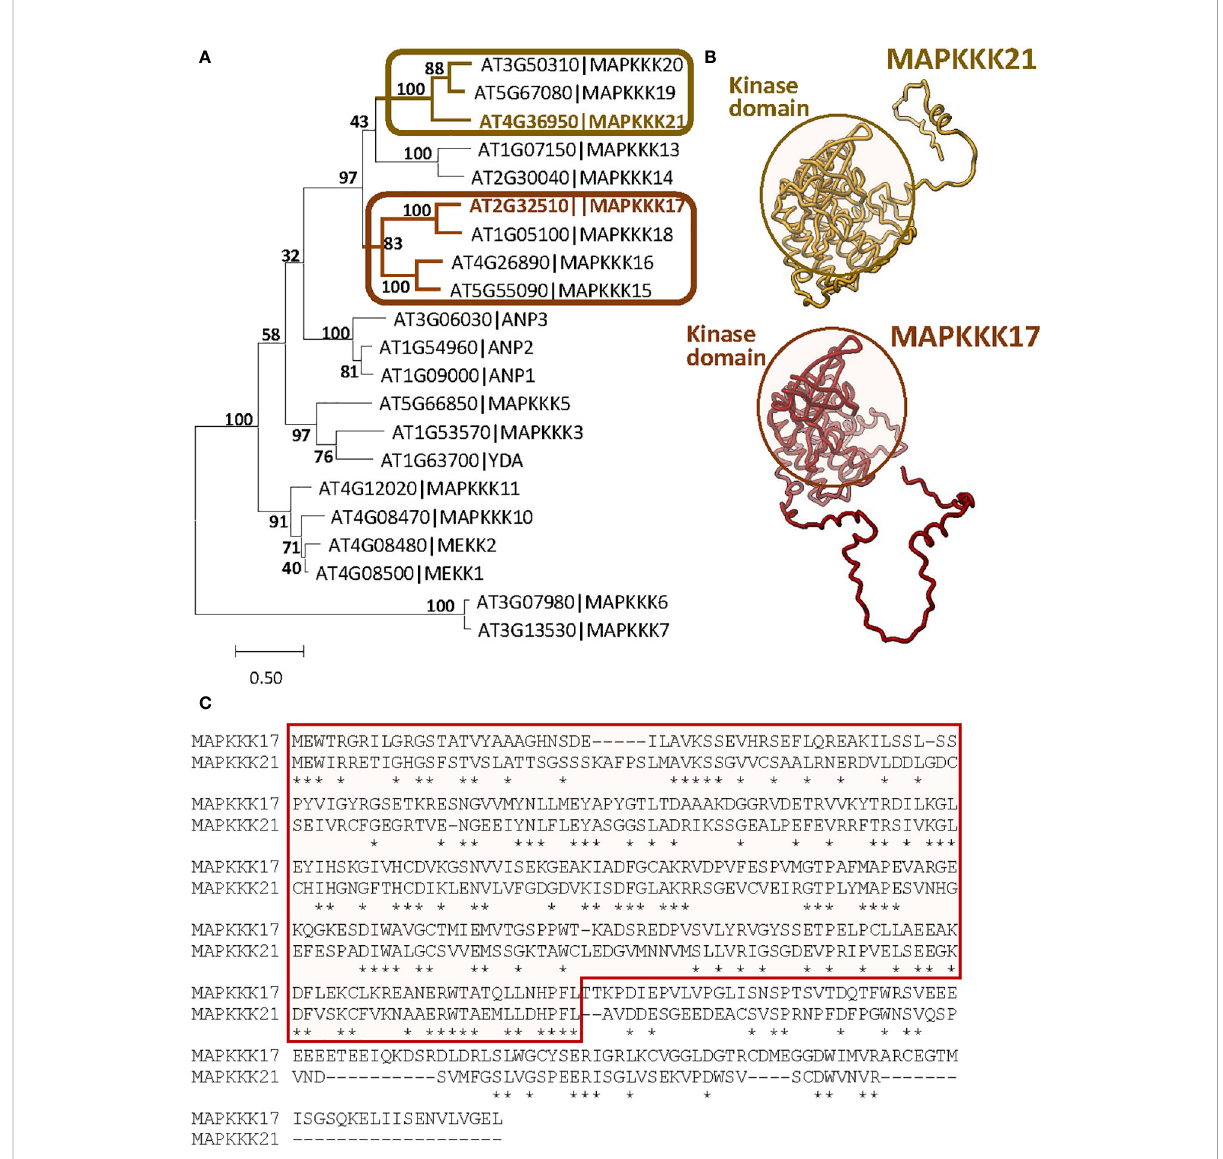
FIGURE 3 Sequence-structure comparison of MAPKKK17 and MAPKKK21. (A) Phylogenetic tree constructed by the maximum likelihood method with the 21 MEKK-like proteins identi fi ed in Arabidopsis. Bootstrap values are shown. Branches containing MAPKKK17 and MAPKKK21 are highlighted. (B) AlphaFold models predicted for MAPKKK17 and MAPKKK21. Kinase domains are circled. (C) Pairwise alignment of the amino acid sequences of MAPKKK17 and MAPKKK21. The kinase domain is squared. Asterisks identi fi ed identical